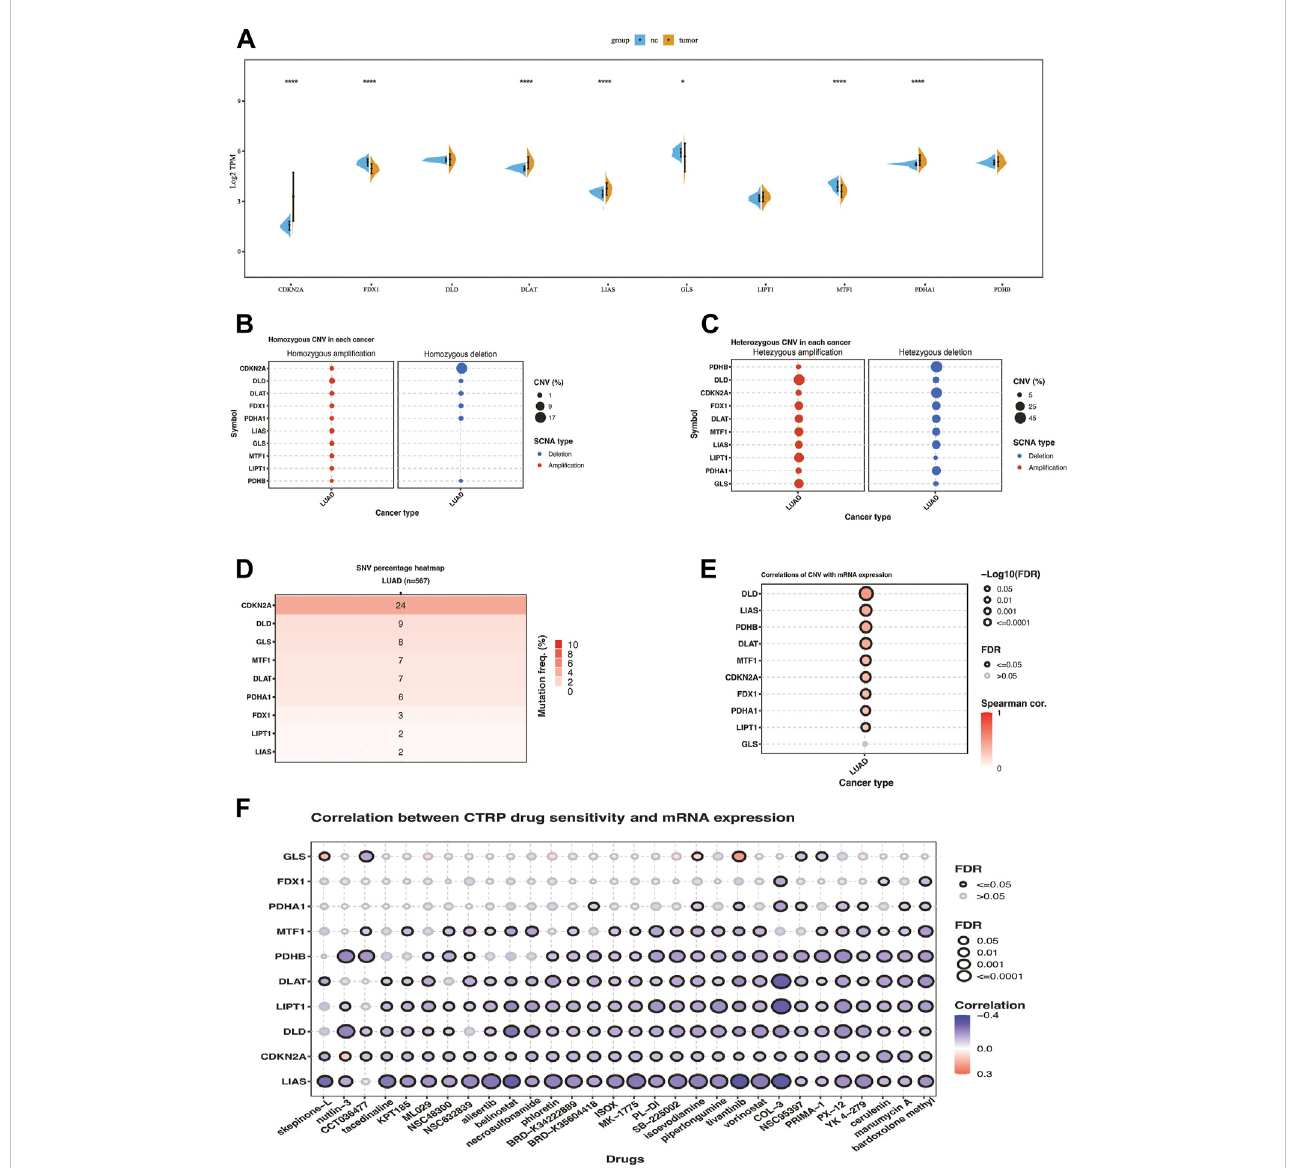
FIGURE 1 Transcriptome and genomic variation of 10 cuproptosis-related genes in TCGA-LUAD. (A) the gene expression difference of 10 cuproptosis genes between NC and lung cancer in TCGA. (B) Homozygous CNV of 10 cuproptosis-related genes in LUAD. (C) Heterozygous CNV of 10 cuproptosis-related genes in LUAD. (D) SNV percentage heatmap of 10 cuproptosis genes in LUAD. (E) Correlations of CNV of ten cuproptosis-related genes with mRNA expression in LUAD. (F) Correlation between CTRP drug sensitivity and mRNA expression of ten cuproptosis-related genes. The symbols *, **, ***, *** corresponded to p < .05, .01, .001, .0001, respectively. p < .05 was regarded as signi fi